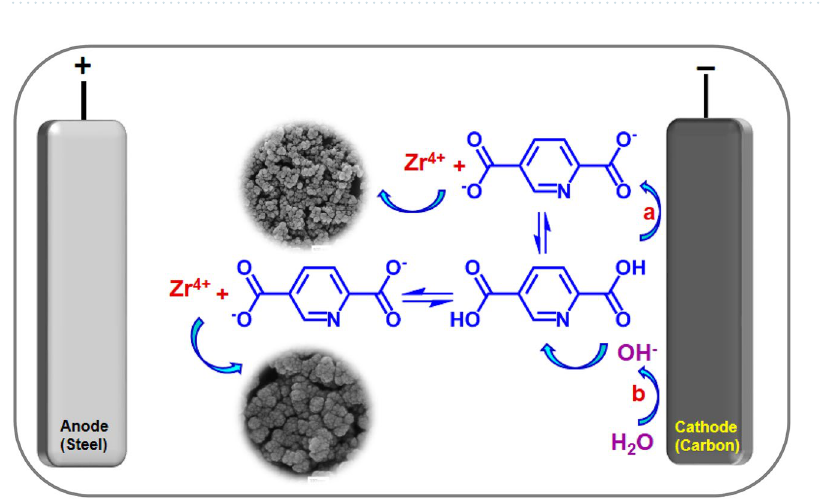
Figure 7. Electrochemical synthesis of (UiO-66-PDC) by constant current electrolysis at I = 30 mA cm −2 and t =